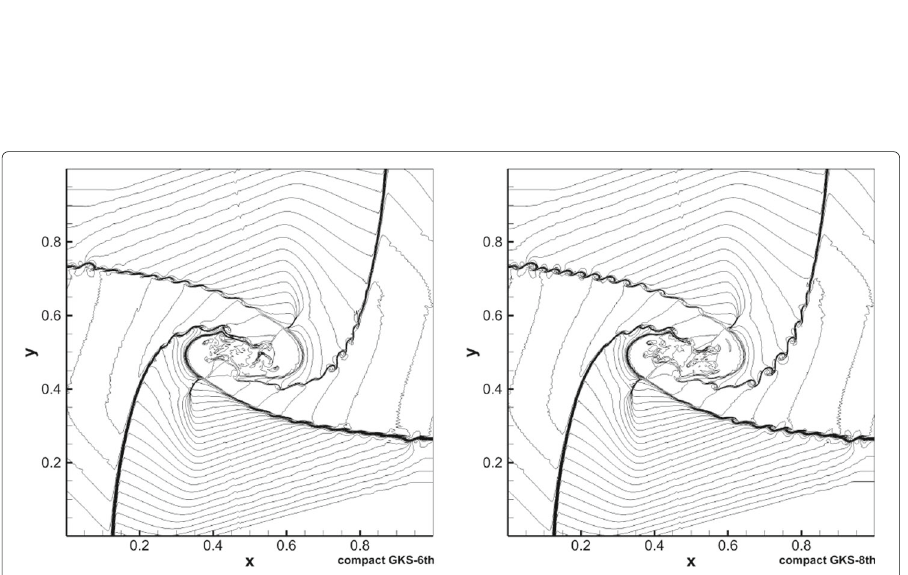
Fig. 16 2D Riemann problem: the density distributions from 6th-order and 8th-order compact GKS for the interactions of four contact discontinuities at t = 0.5 with 500 × 500 mesh